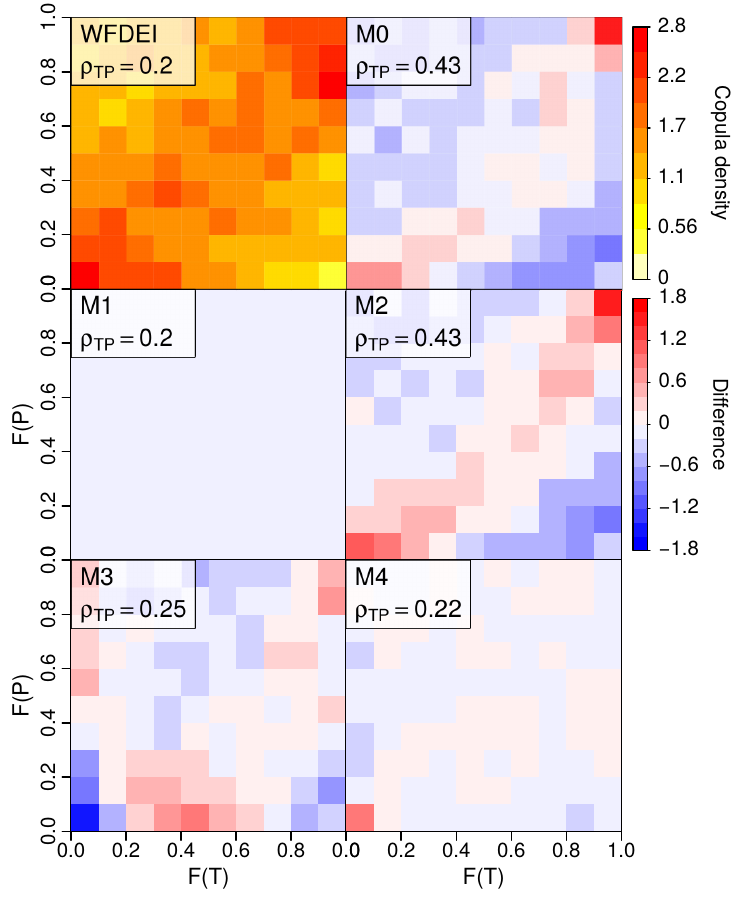
Figure 2. Empirical copula density of wet-day (P > 0.1 mmd − 1 ) precipitation and temperature in winter months (December-January-February) estimated from the reference data (WFDEI) in Tornio river catchment separately for each sub-basin and then averaged over the whole domain. In addition, differences in the estimated densities, when compared against WFDEI, are shown for CNRM-A GCM-RCM without bias adjustments (M0) and after applying each of the four methods (M1–M4) in the baseline period (1981–2010). The sub-model-averaged Pearson correlation coefficient is also shown on the top-left corner of each